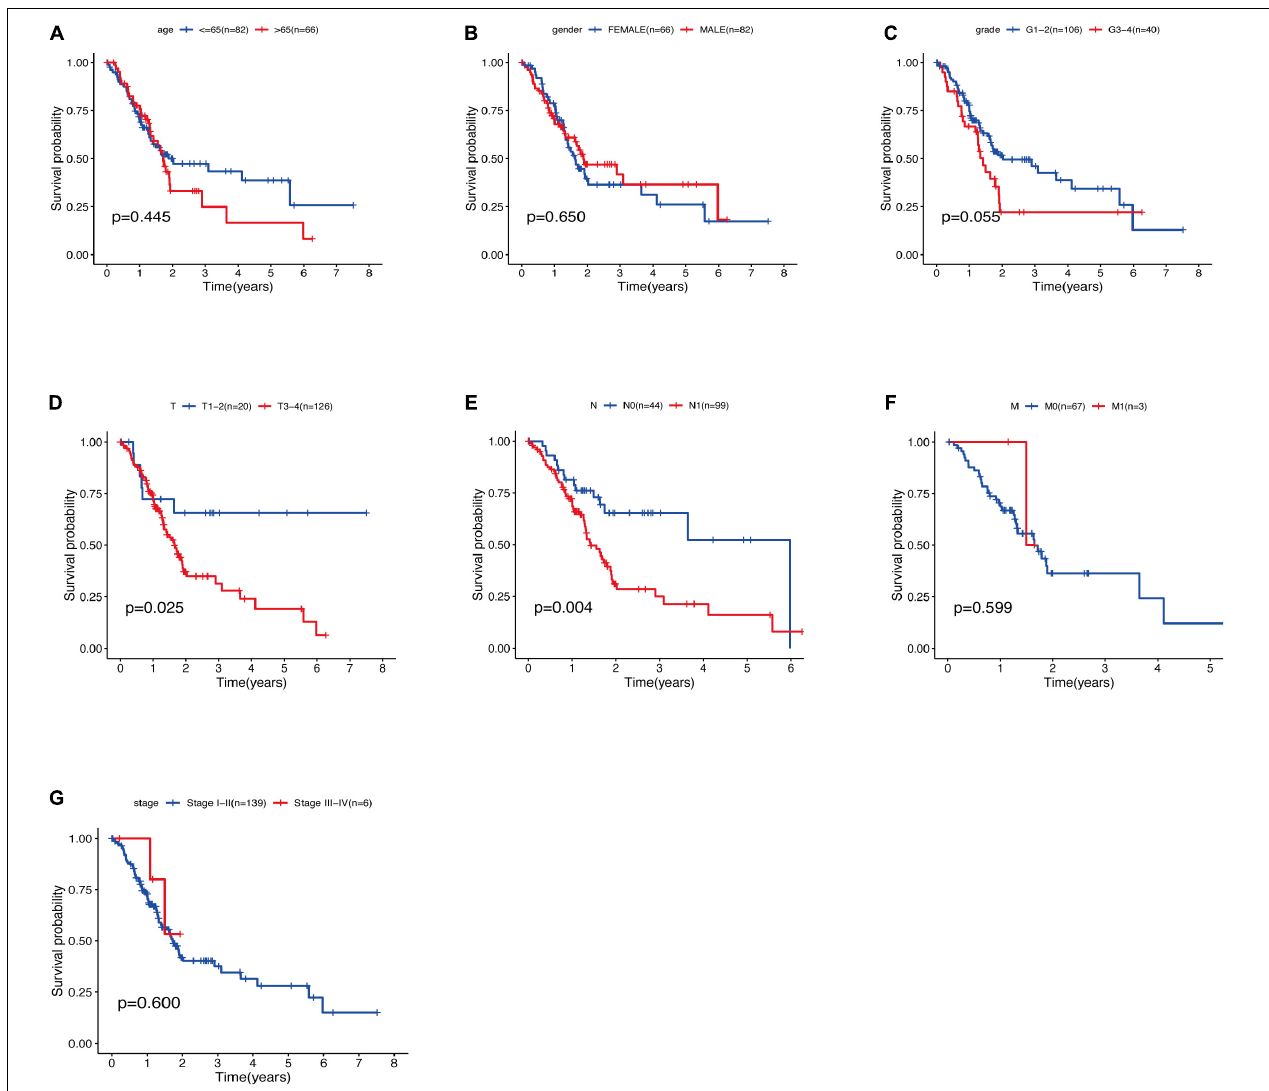
FIGURE 9 | (A) Relationship between age and survival of patients with PDAC. (B) Relationship between gender and survival of patients with PDAC. (C) Relationship between grade and survival of patients with PDAC. (D) Relationship between T stage and survival of patients with PDAC. (E) Relationship between N stage and survival of patients with PDAC. (F) Relationship between M stage and survival of patients with PDAC. (G) Relationship between stage and survival of patients with